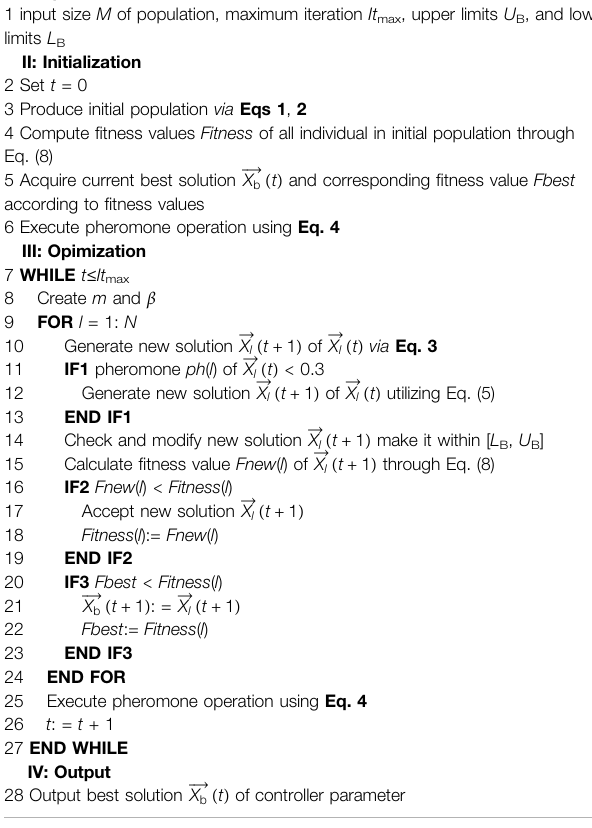
TABLE 2 | Parameter optimization pseudocode of controller based on